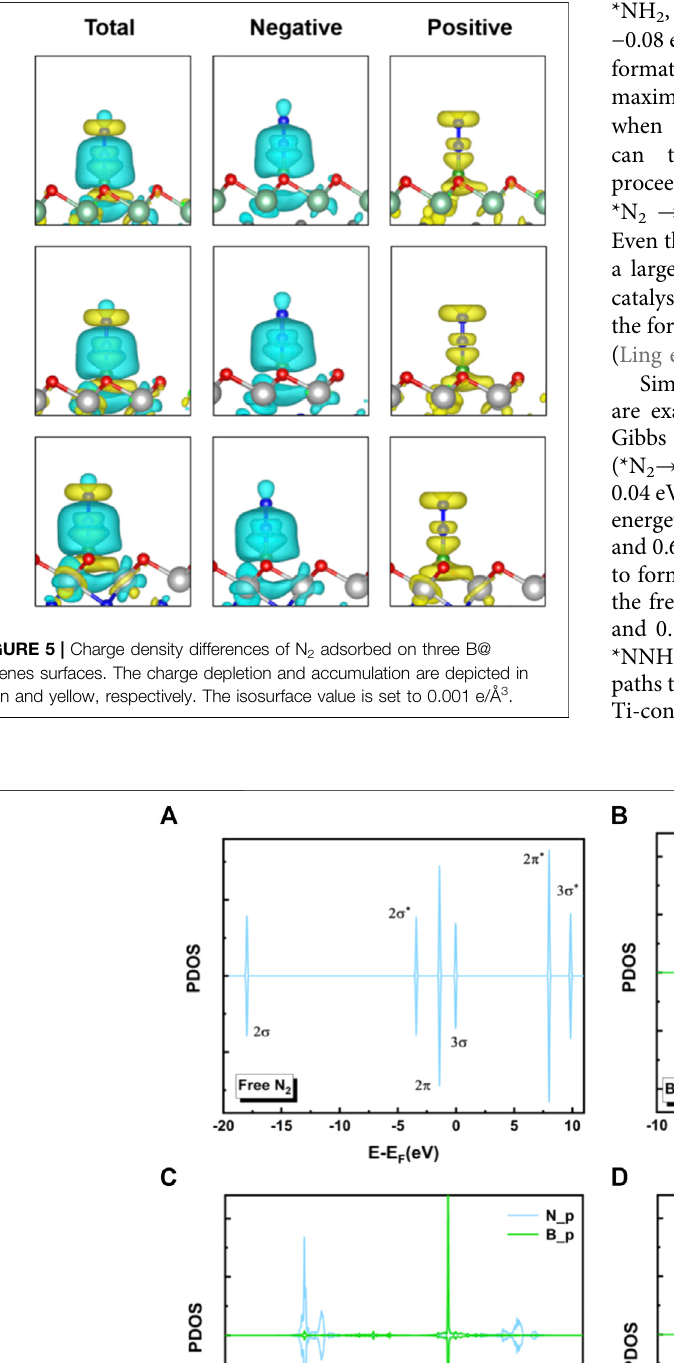
Frontiers in Chemical Engineering |